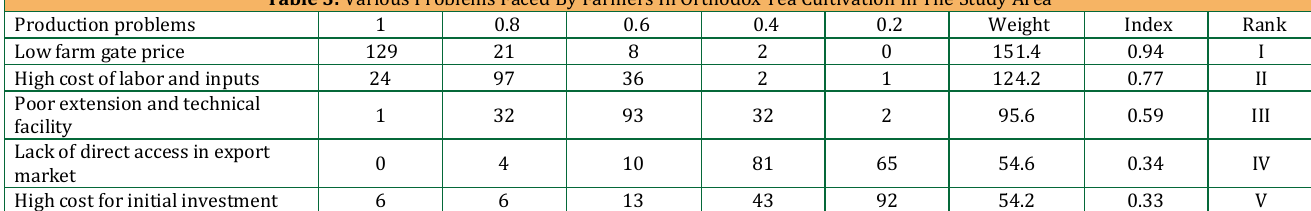
Table 3: Various Problems Faced By Farmers In Orthodox Tea Cultivation In The Study Area